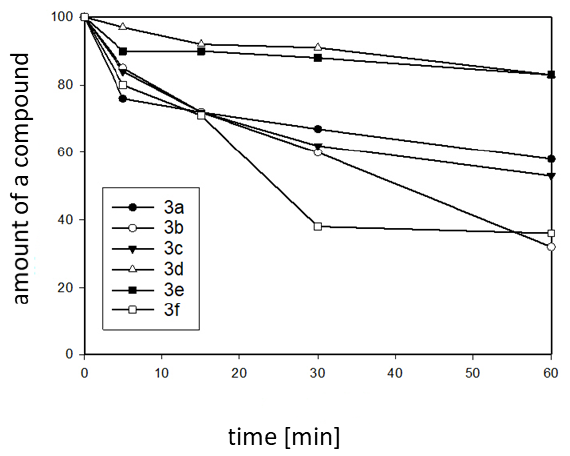
Figure 5. Plot presenting the decomposition rate of compounds 3a – f in a water environment.